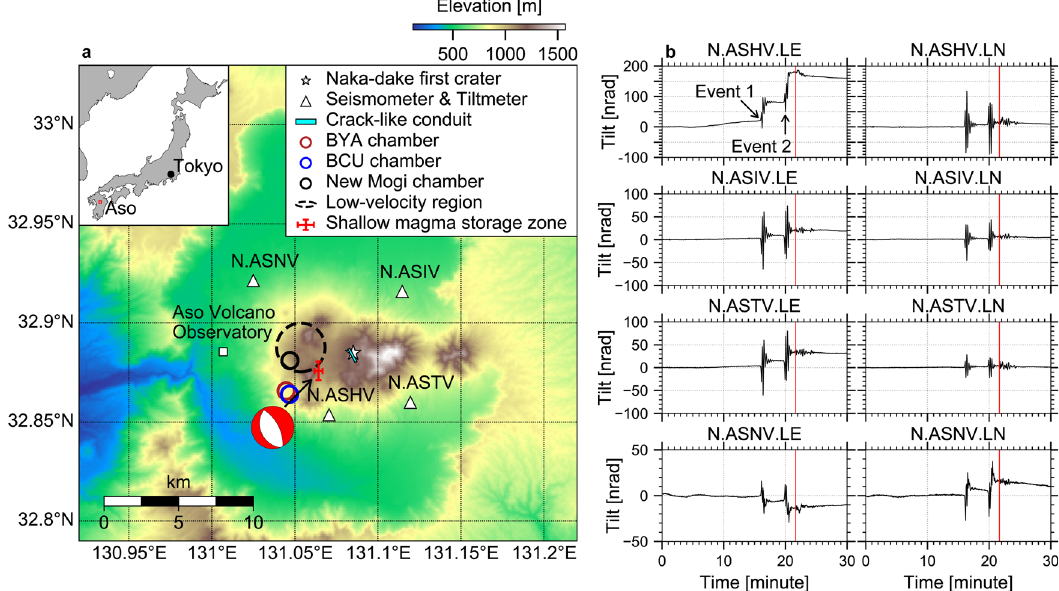
Fig. 1 Aso volcano system and observations of synchronous VLP and tilt offset. a The topographic relief near the Aso caldera is overlaid with collocated seismometer and tiltmeter (open triangles), VLP source in the shallow crack-like conduit 29 (thick bar), the geodetically inferred magma chamber 45,46 (open circle), and the low-velocity zone 47 (dashed circle). BCU and BYA chambers are inferred from levelling data in 1993 – 1994 and 1993 – 2004, respectively 45 . New Mogi chamber is inferred from GNSS (2004 – 2008) and levelling data (1998 – 2008) 46 . The star marks the active Naka-dake fi rst crater. The upper inset displays Aso volcano located in Kyushu Island, southwest Japan. The source of the tilt offset is marked as a red cross, corresponding to a shallow magma storage zone (SMSZ) connected to the top of the chamber roof. The beach ball displays the deviatoric component of the source moment tensor. The depths of BCU, BYA, new-Mogi, low-velocity zone, and crack-like conduit can be referred to Fig. 3c. b Tilt waveforms at four V-net stations near the October 8, 2016 phreatomagmatic eruption. The waveforms are low-pass fi ltered at 0.05 Hz with a 4 th -order casual Butterworth fi lter. The linear trend determined in the fi rst 10 min is used to remove the background trend. “ LE ” and “ LN ” denote eastside and northside down tilts, respectively. “ Event 1 ” and “ Event 2 ” denote the tilt offset that occurred concurrently with two VLPs. The red line marks the timing of the 2016 eruption.